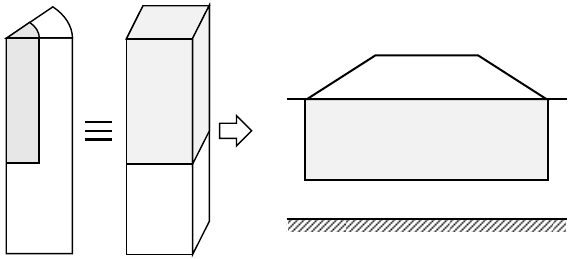
Figure 9. Calibration of the parameters of the equivalent homogeneous soil using the unit cell model as an auxiliary problem.